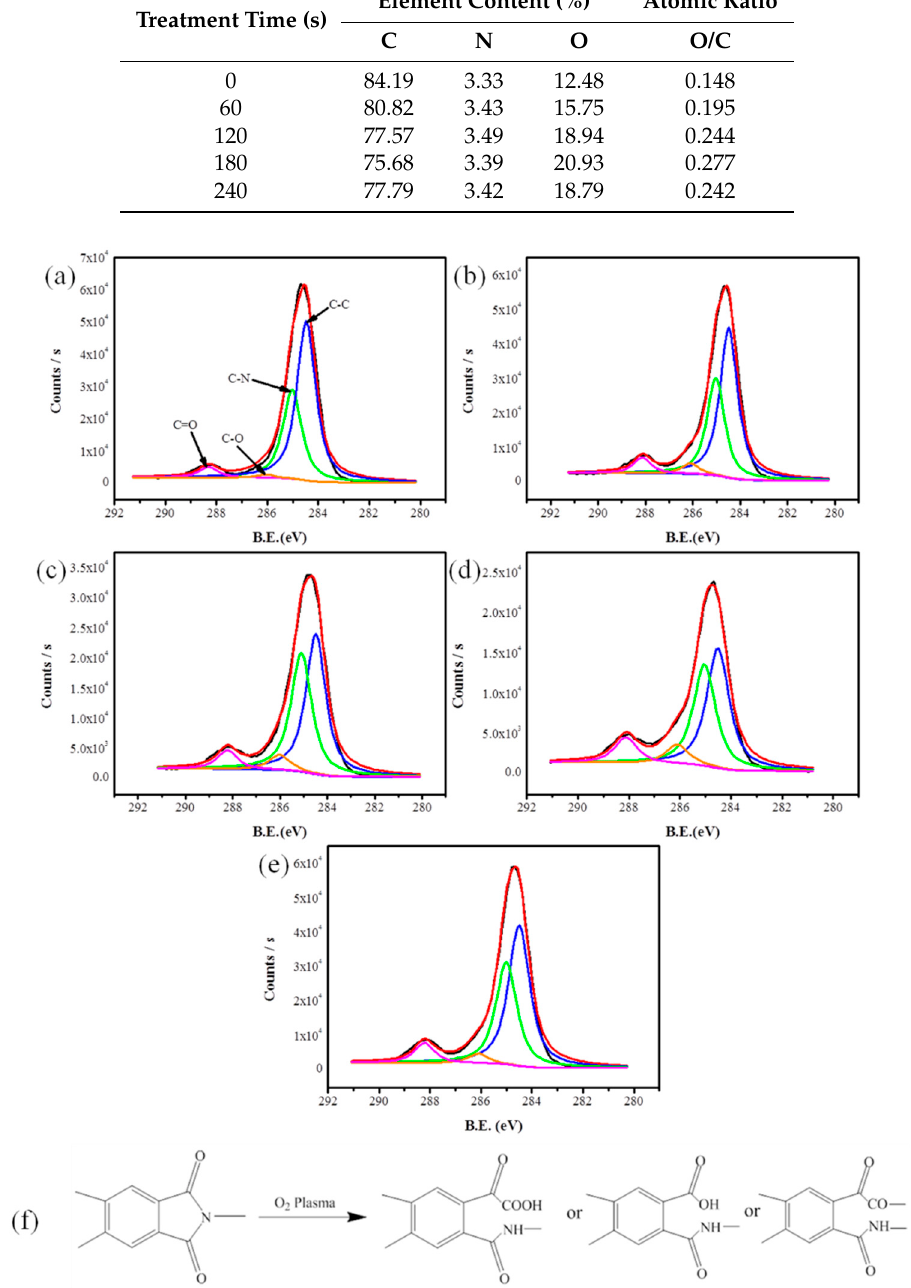
Table 1. Surface elemental compositions of PI filaments with and without O 2 plasma treatment. Table 2. The content of functional groups of PI filaments with and without O 2 plasma treatment.